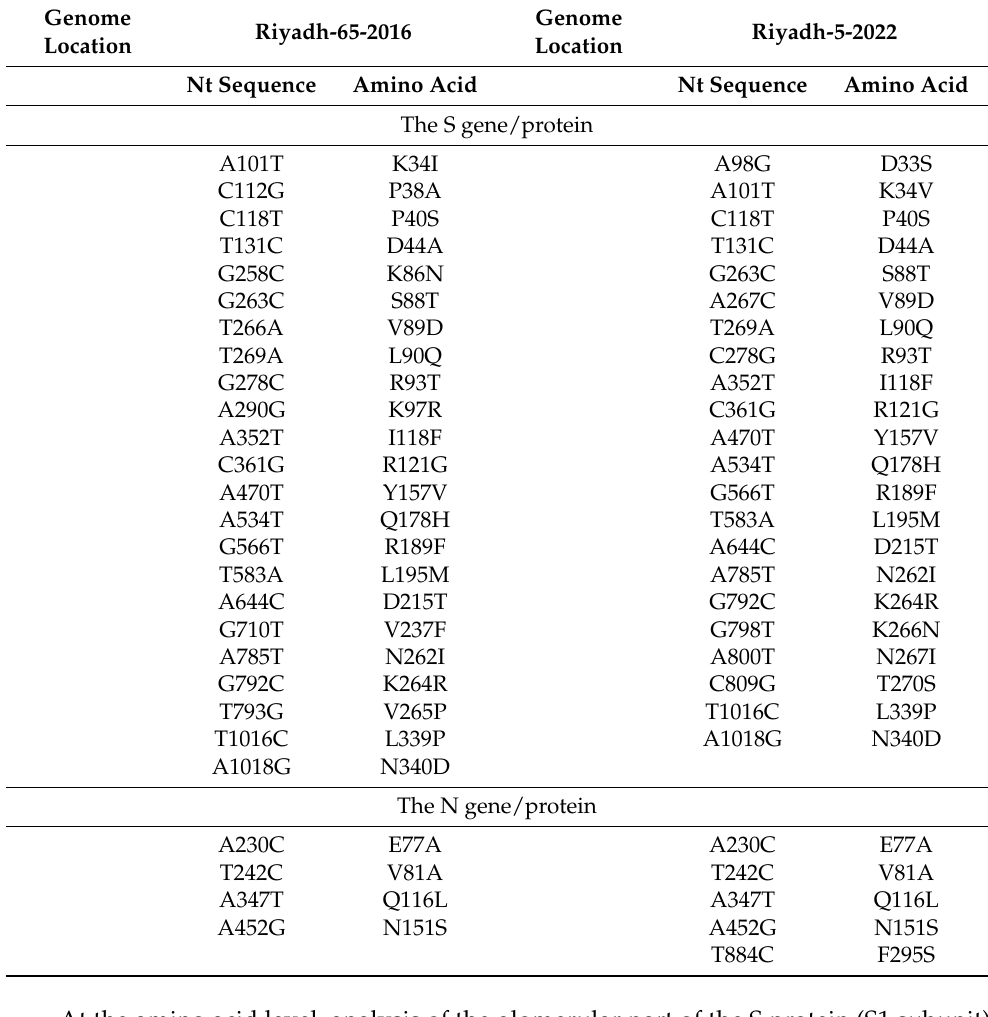
Table 3. Mutation record of nucleotides and amino acids